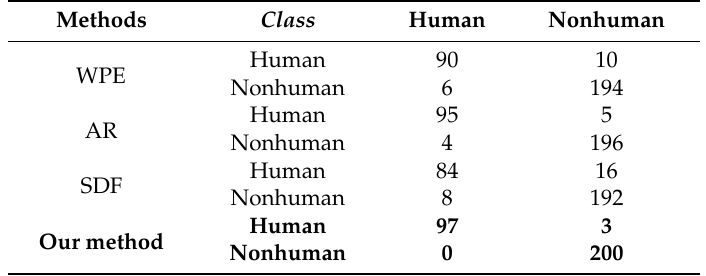
Table 8. Recognition results of each method in the experiments executed on Database 2.